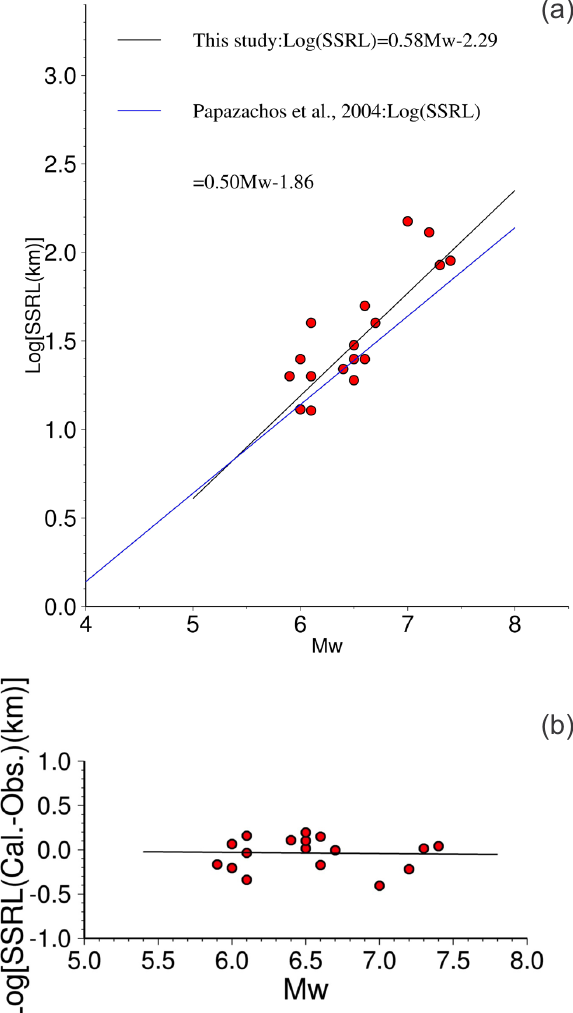
Figure 8. (a) Relation between SRL and M plate earthquakes; (b) reliability test for this diagram.